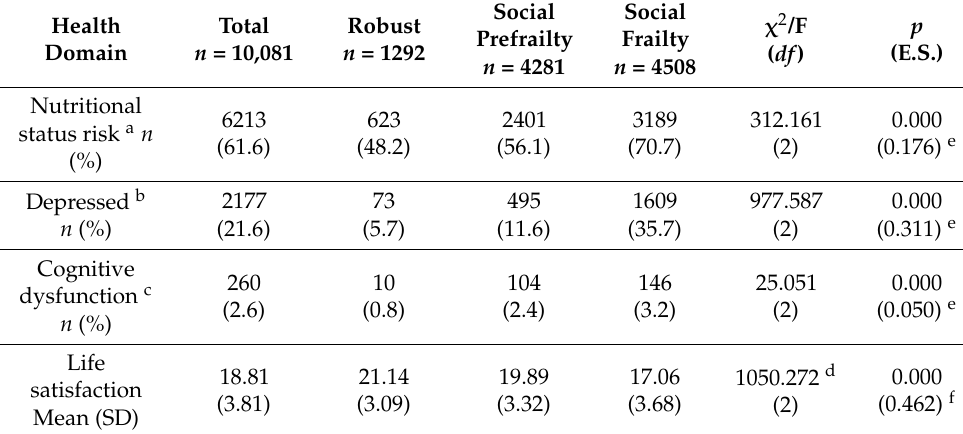
Table 2. Prevalence of social frailty in different health